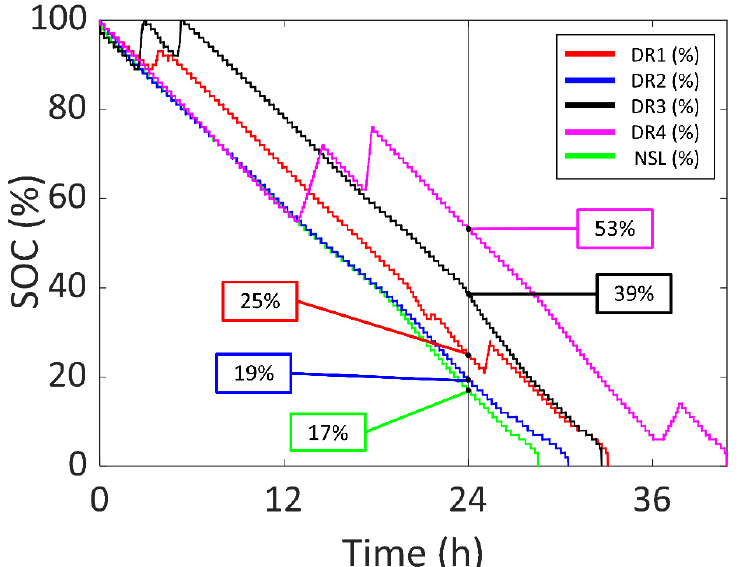
Figure 12. SOC vs. time of the second set experiments and NSL.